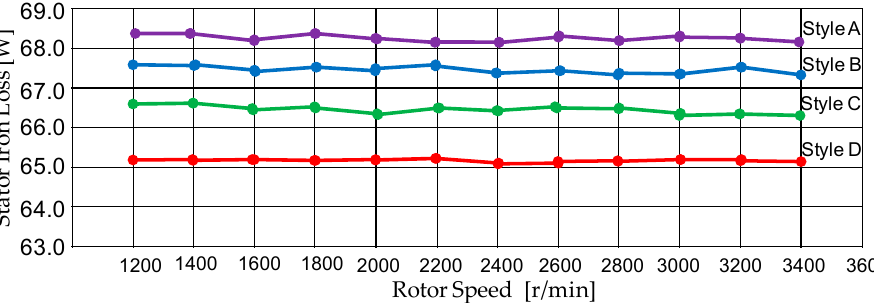
Figure 6. Poly-line graph of stator copper loss for four kinds of SCSCRIMs under several speeds.